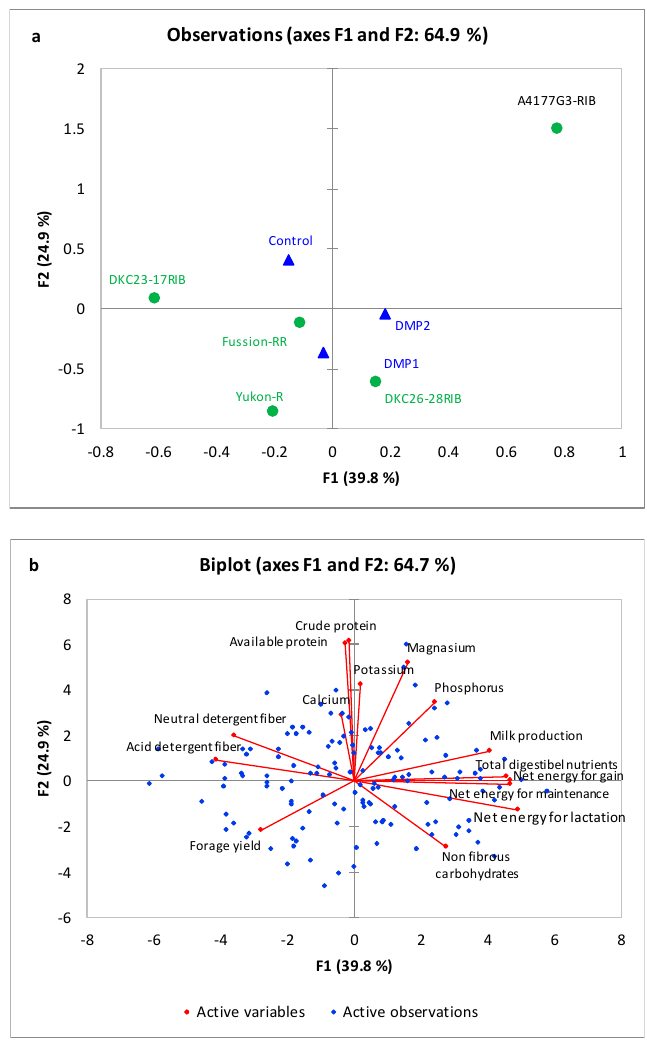
Figure 8. Principal component analysis (PCA) observation plot ( a ) and biplot ( b ) of the first two components performed on the forage yield and forage quality of five silage-corn genotypes a ff ected by organic (DMP1 and DMP2) and inorganic P amendments. Centroids showing segregation of silage corn genotypes and P amendments on axis F1 and F2 based on forage production and forage quality.